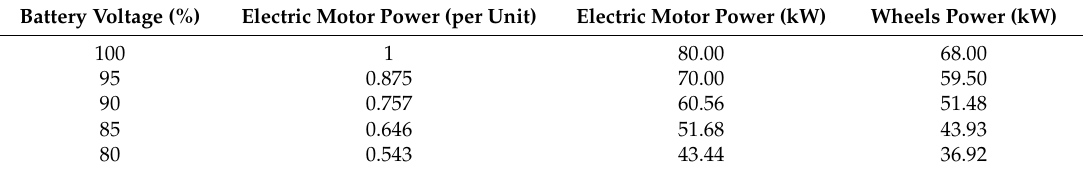
Table 2. Application example: power reduction function effect and resulting power at the wheels.